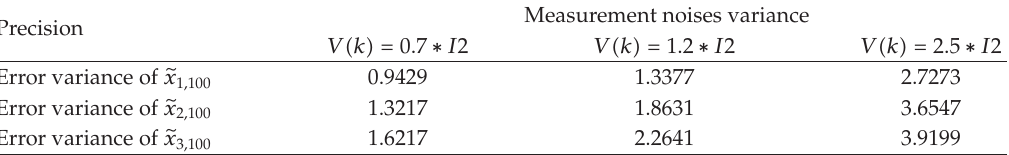
Table 1: Variation of error variance with di ff erent measurement noises variance.